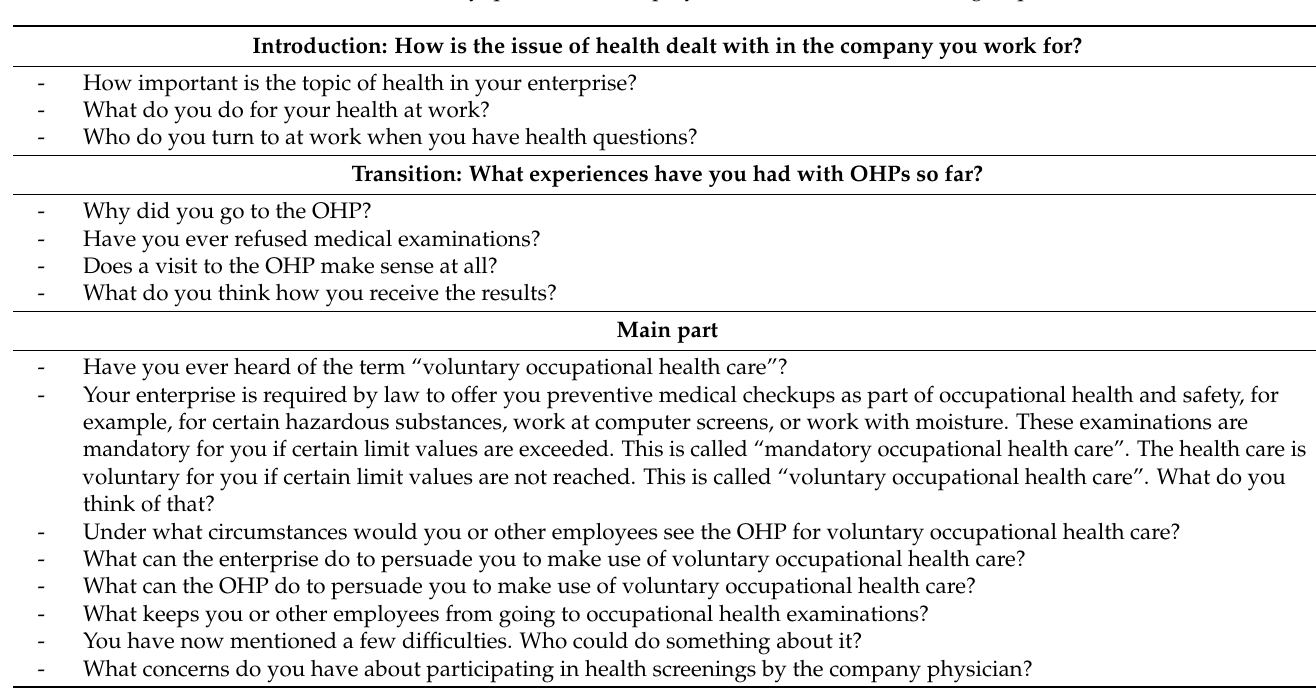
Table A2. Key questions for employees in interviews and focus group